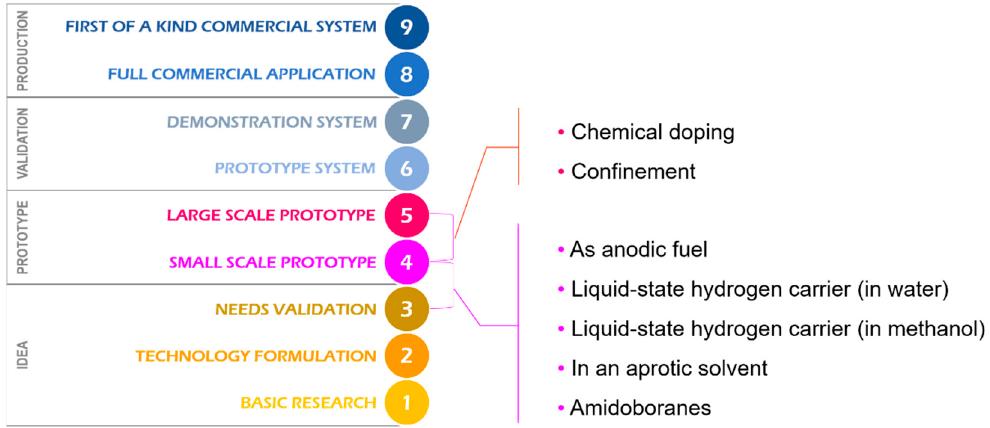
Figure 22. Estimation of the technological readiness level of ammonia borane as an anodic fuel, a liquid-state hydrogen carrier and a solid hydrogen carrier. The prototypes reported in ref. [237] and in ref. [335] have been taken into account to take the chemical doping and confinement strategies to a higher level than the other approaches.